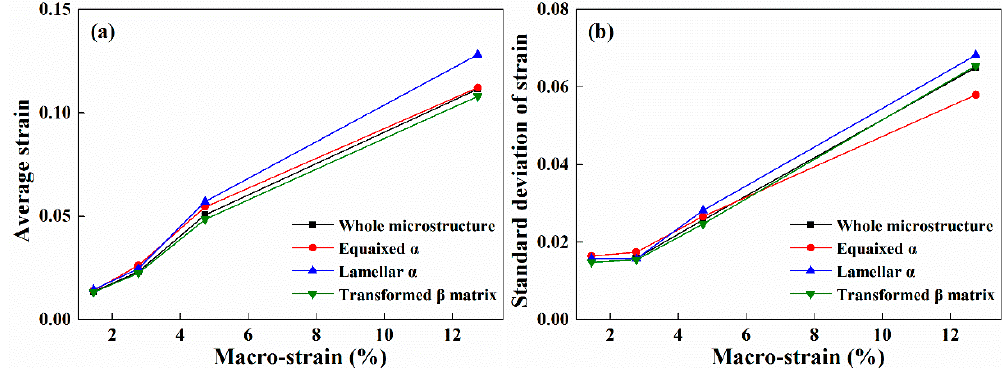
Figure 6. Variations of average ( a ) and standard deviation ( b ) of strain in the whole microstructure and different constituents.